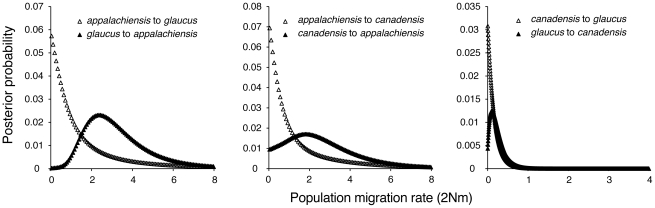
Estimated gene flow among appalachiensis, glaucus, and canadensis.Gene flow was estimated as the population migration rate or 2Nm, which is equivalent to the historical average number of immigrants between species per generation: glaucus to appalachiensis: 2.3; canadensis to appalachiensis: 1.8; appalachiensis to either glaucus or canadensis: 0; glaucus to canadensis: 0.1; canadensis to glaucus: 0.